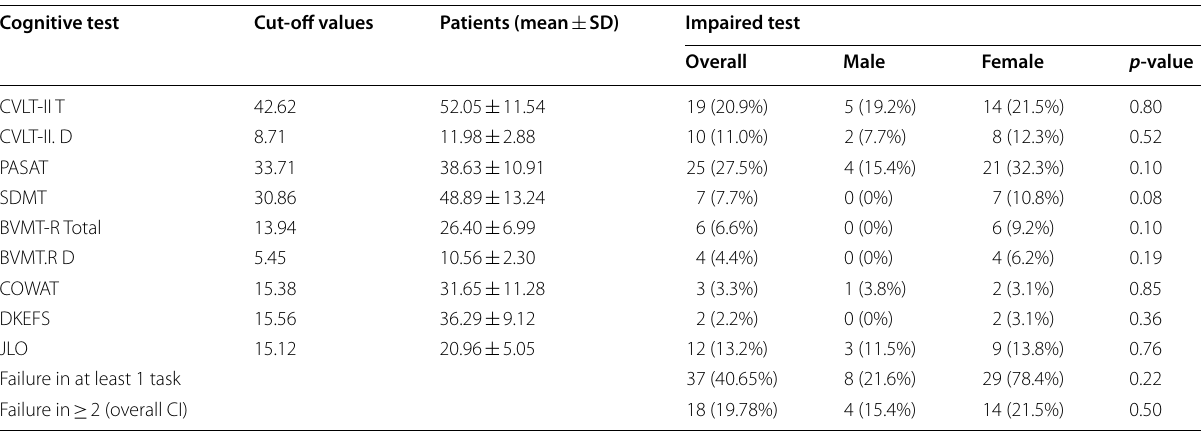
Table 2 Mean scores of each MACFIMS test, cut‑off values and number of patients with impairment